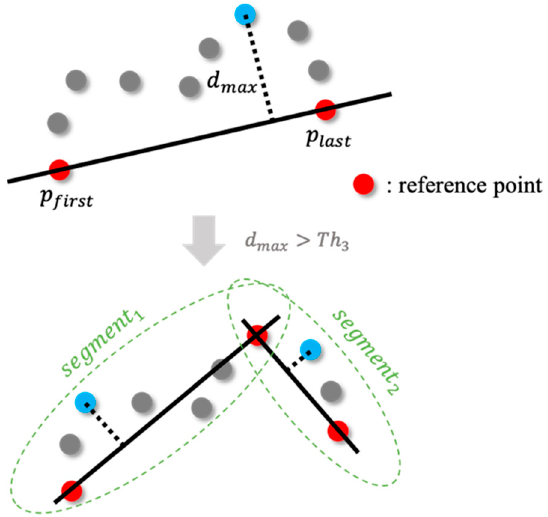
Figure 10. The process of the Douglas–Peucker algorithm.